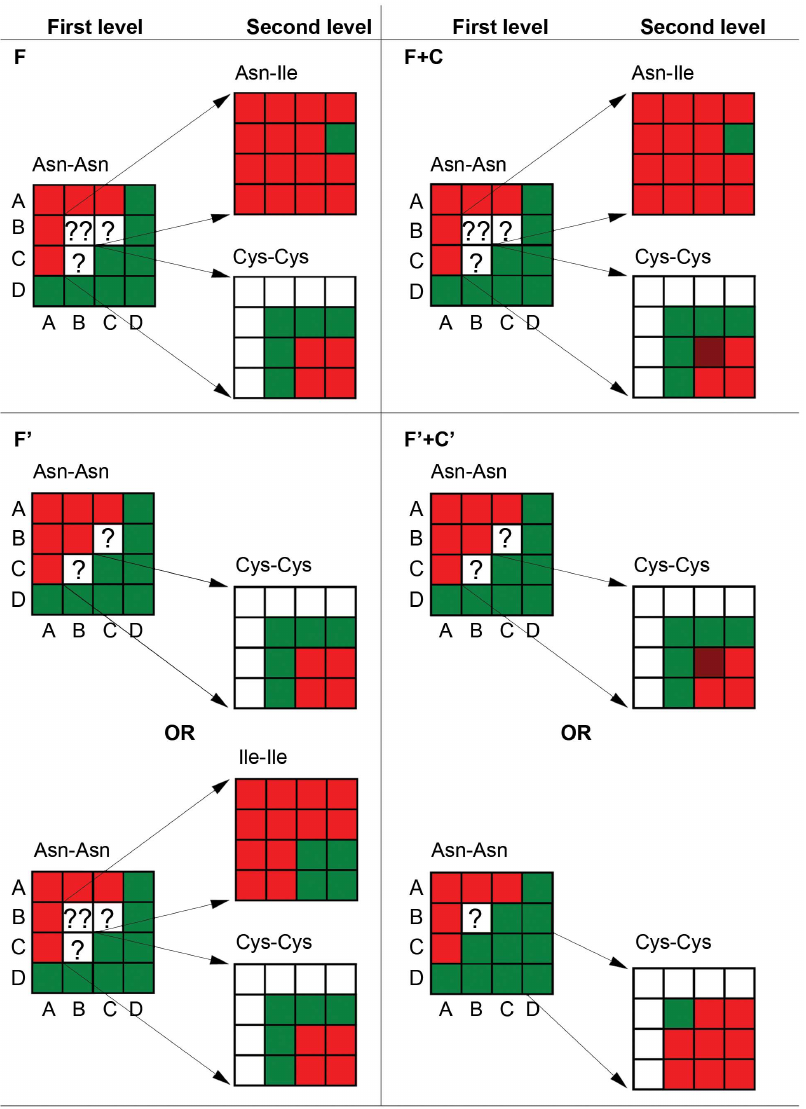
Figure 2. Synthesis of several decision trees generated during the ML training. The aa at the top of each box is relative to the attributes specified at the first and second level of the trees. A, B, C and D indicate the low, moderate, high and very high bins, respectively (for more details, see Table 3 and the ‘‘Materials and Methods’’ section). Green boxes, a combination that classifies an instance as a PPI; Red boxes, a combination that classifies an instance as a no-PPI; Brown boxes, a combination that classifies an instance as a PPI or no-PPI; ‘‘?’’, a combination for which an instance can not be classified, requiring classification at the next level of the tree.